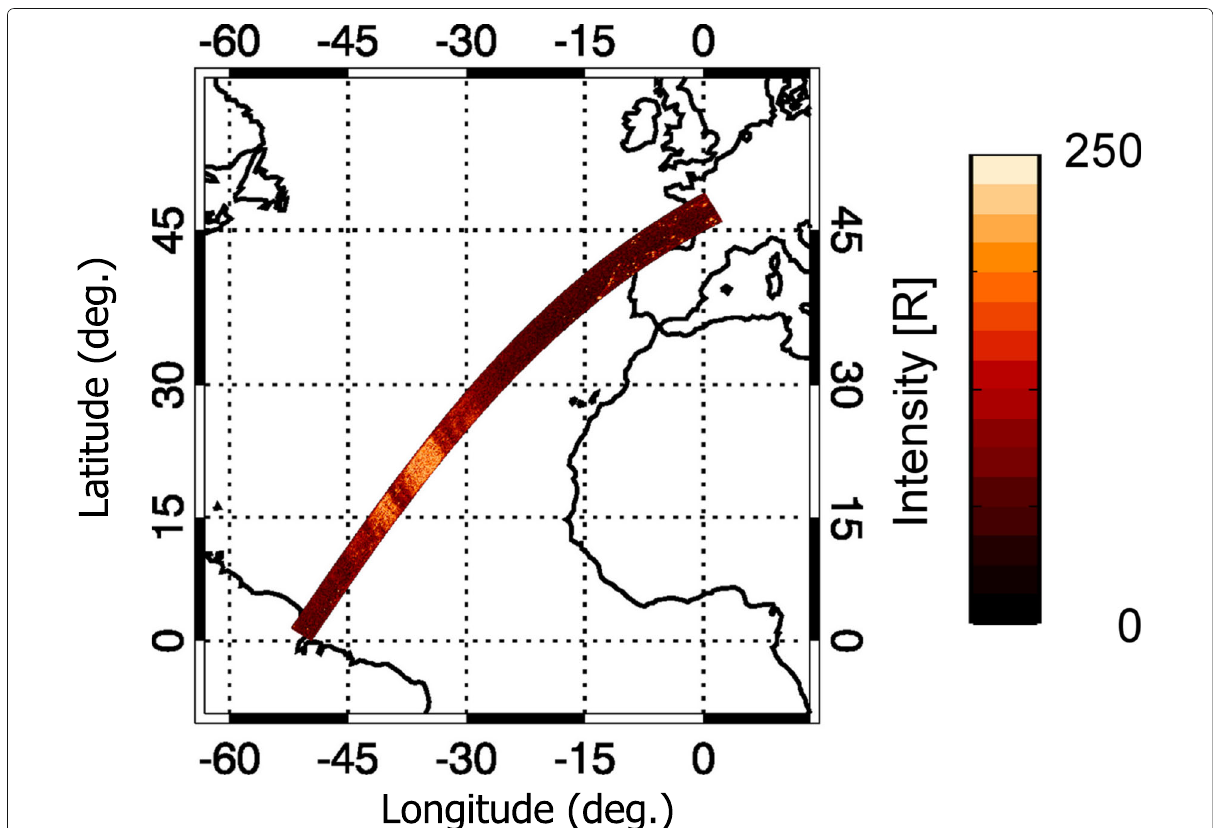
Fig. 1 The 630 nm airglow image along the track of the ISS observed at 02 UT on 25 September 2012